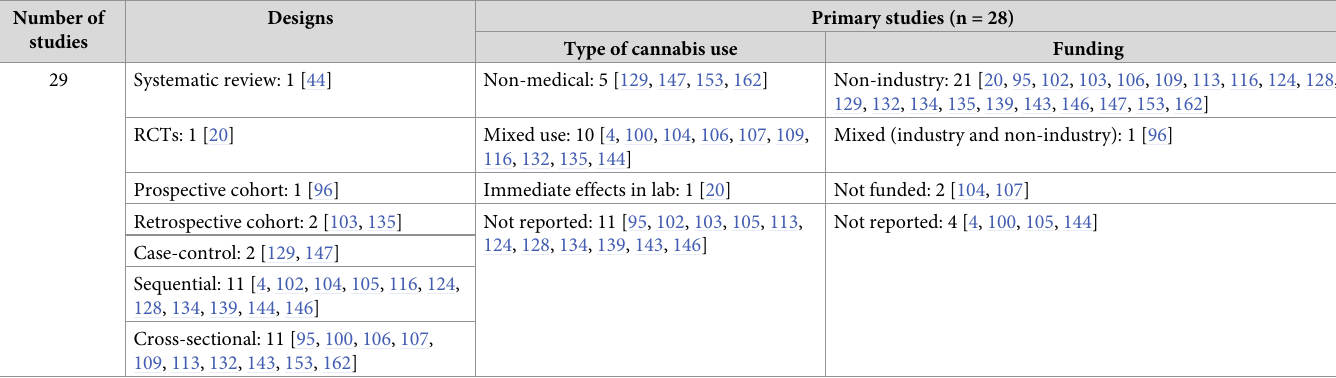
Table 3. Characteristics of population-based studies and studies of healthy older